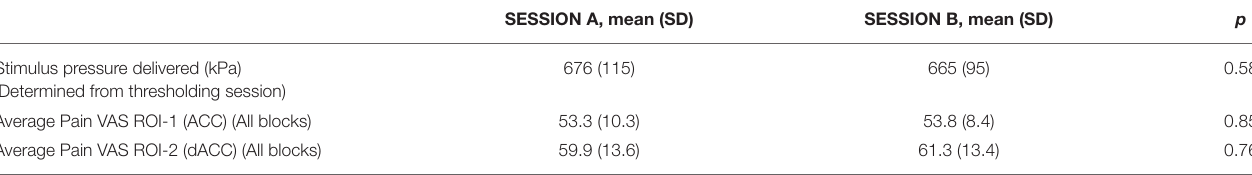
TABLE 1 | Mean stimulus pressure values and pain VAS scores.